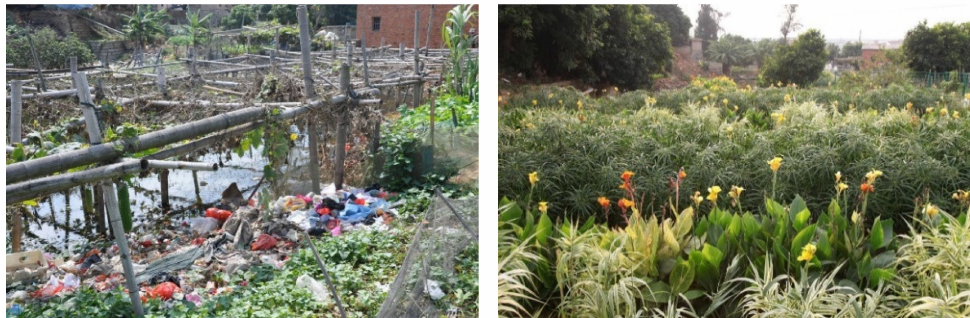
Figure 8. Pond before construction ( left ) and constructed wetland after construction ( right ).